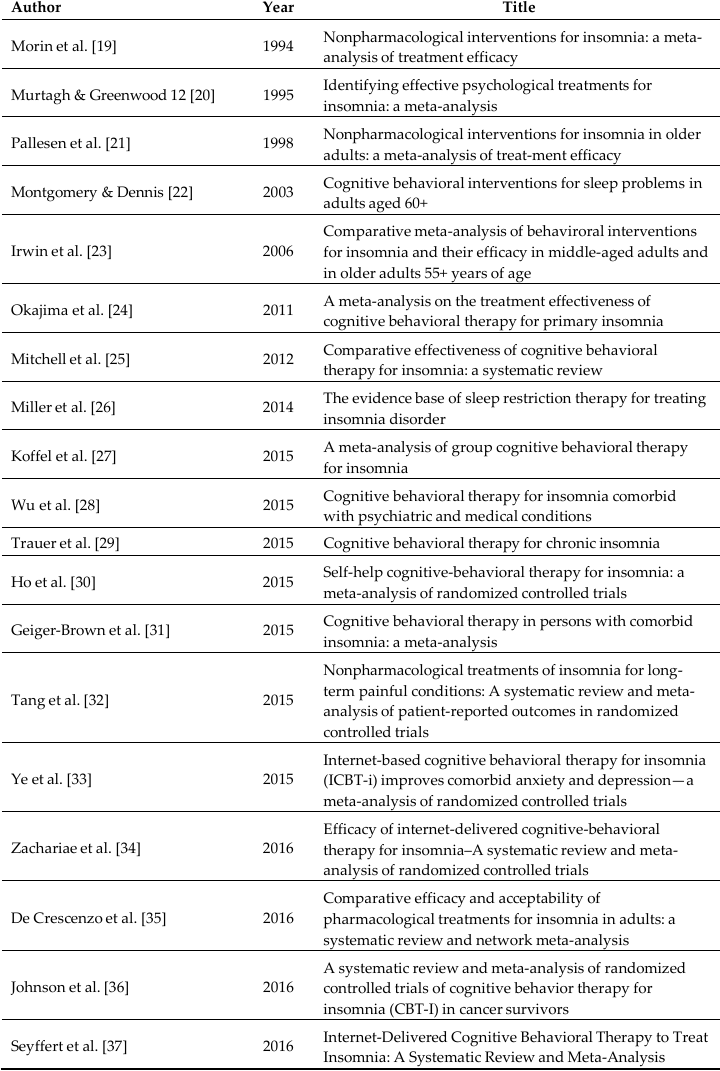
Figure 1. An overview of CBT-I meta-analyses.